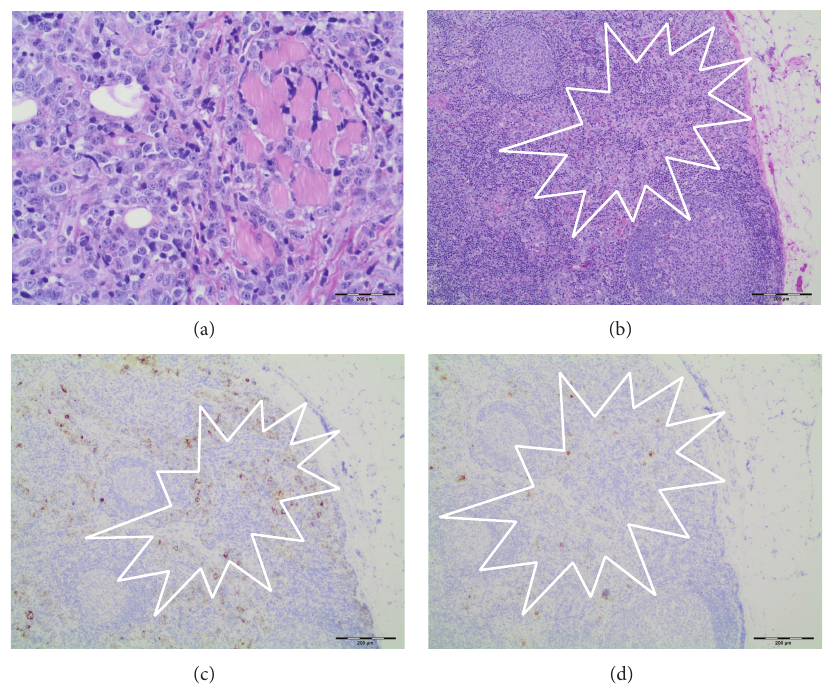
Figure 2: (a) Myeloid sarcoma blasts infiltrating striated muscle in biopsy from eyebrow. (b) Inguinal lymph node showing myeloid blasts in subcapsular and interfollicular sinuses (H&E). (c) Immunoperoxidase staining for CD42b showing positivity in blasts infiltrating lymph node subcapsular and interfollicular sinuses. (d) Immunoperoxidase staining for CD61 showing positivity in blasts infiltrating lymph nose subcapsular and interfollicular